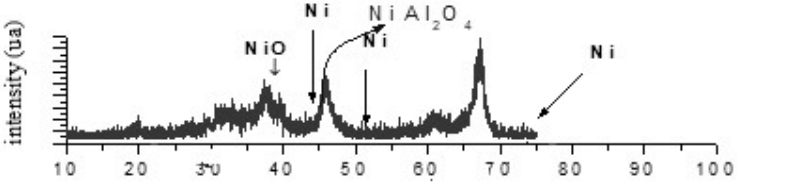
Figure 1. X-ray diffraction (XRD) analysis of the nickel catalyst supported on gamma alumina (Ni (4.82 wt.%)/ γ -Al 2 O 3 ).